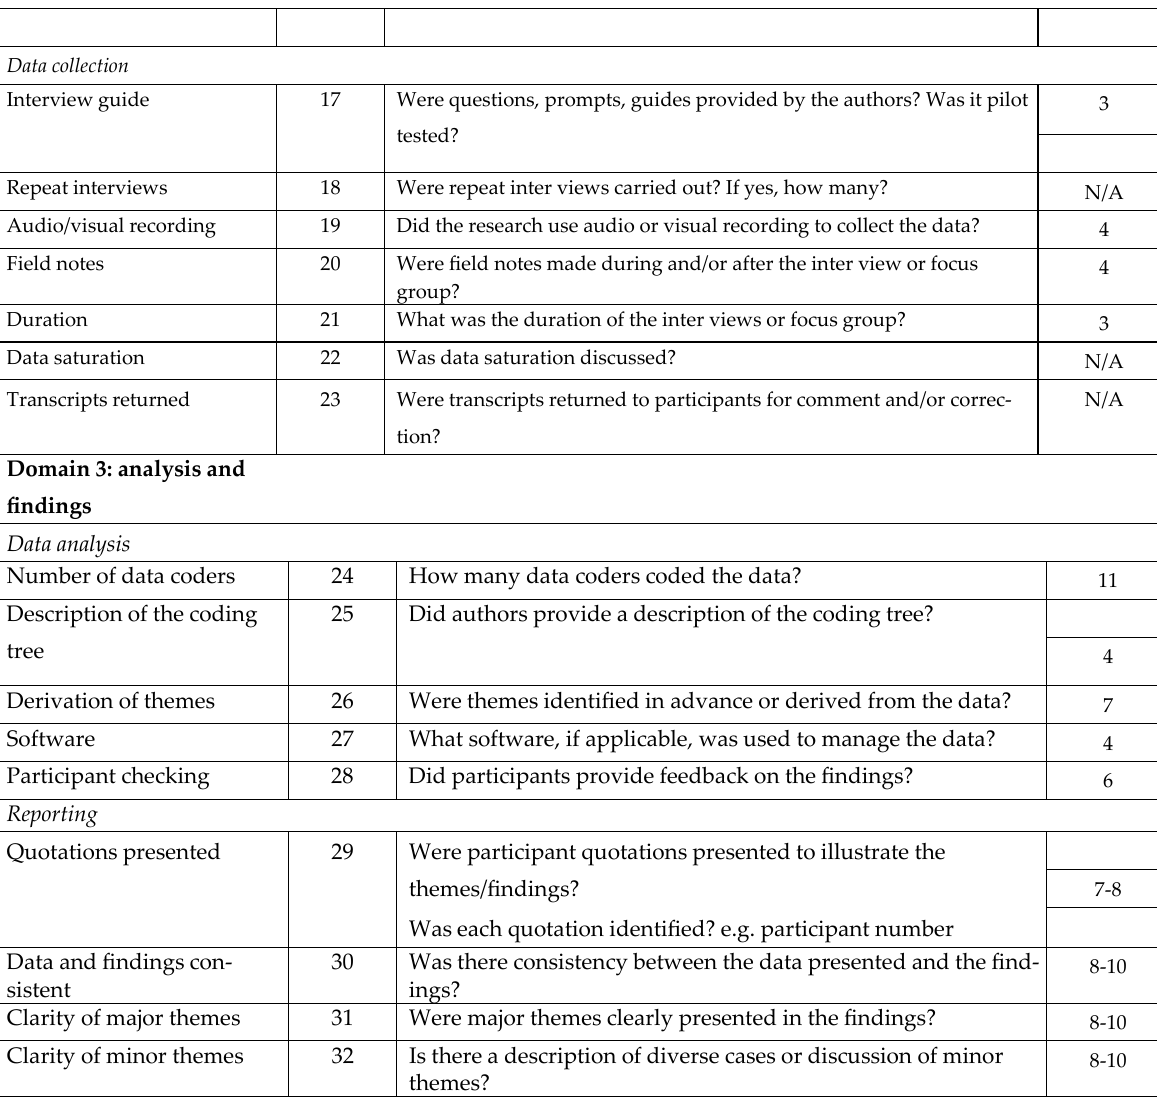
Figure A1. Consolidating criteria for reporting qualitative research (coreq): a 32-item checklist for interviews and fo- cus groups.